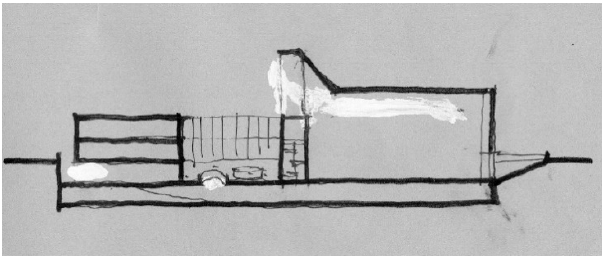
Figure 1. Concept massing model for the first design iteration facing Sheppard Avenue (Credit: Larkin Architect Limited).